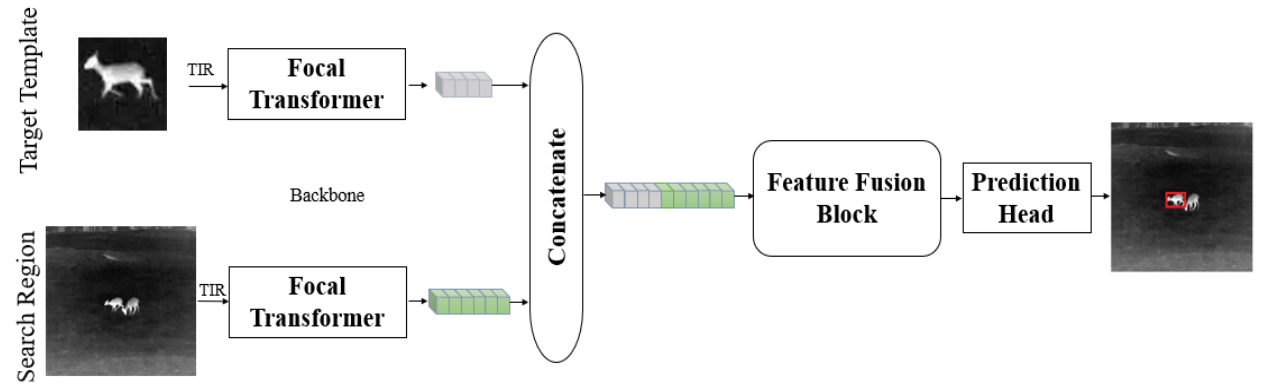
Figure 2. The overall framework of the TIR target tracker.